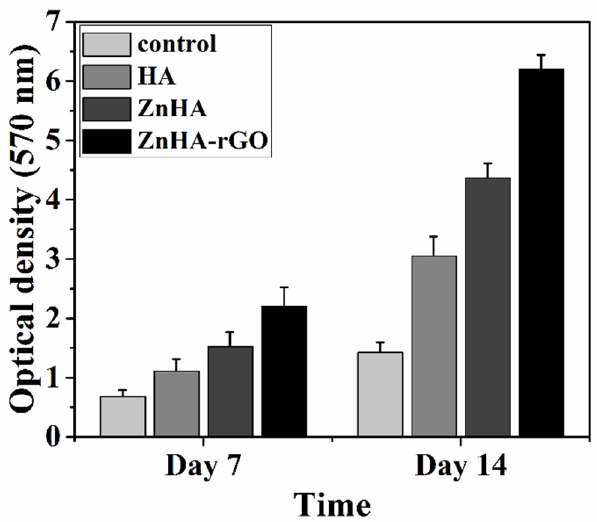
Figure 4. The viability of MSCs incubated in culture media treated by the HA, ZnHA, and ZnHA-rGO nanoparticles using MTT assay. During the incubation period (14 days), the presence of nanoparticles caused an appreciable increase in cell proliferation, especially ZnHA-rGO, compared to the non-treated control.